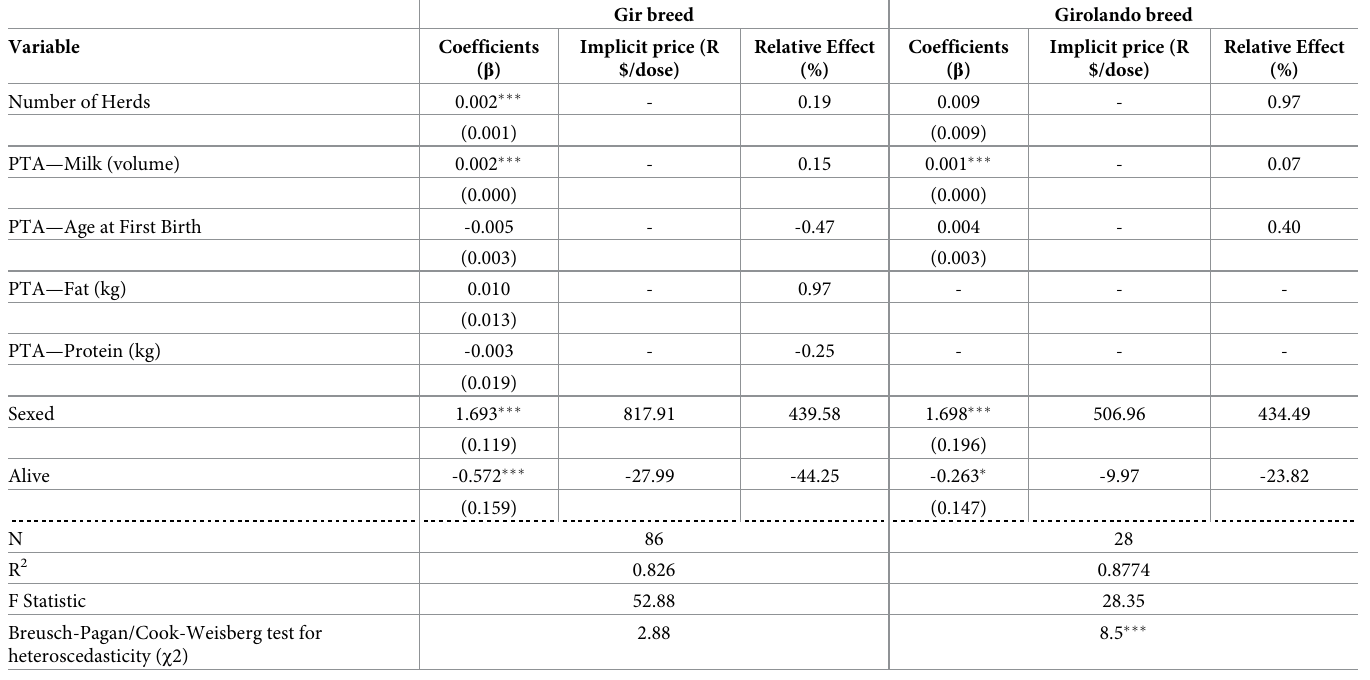
Table 5. Estimated parameters and implicit attribute prices for semen of dairy